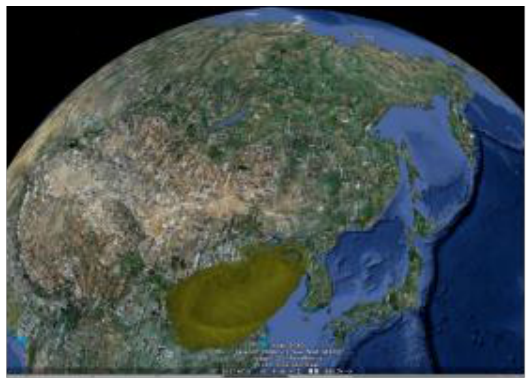
Fig. 5 Asian dust cloud at 00:00 on March 20, 2010